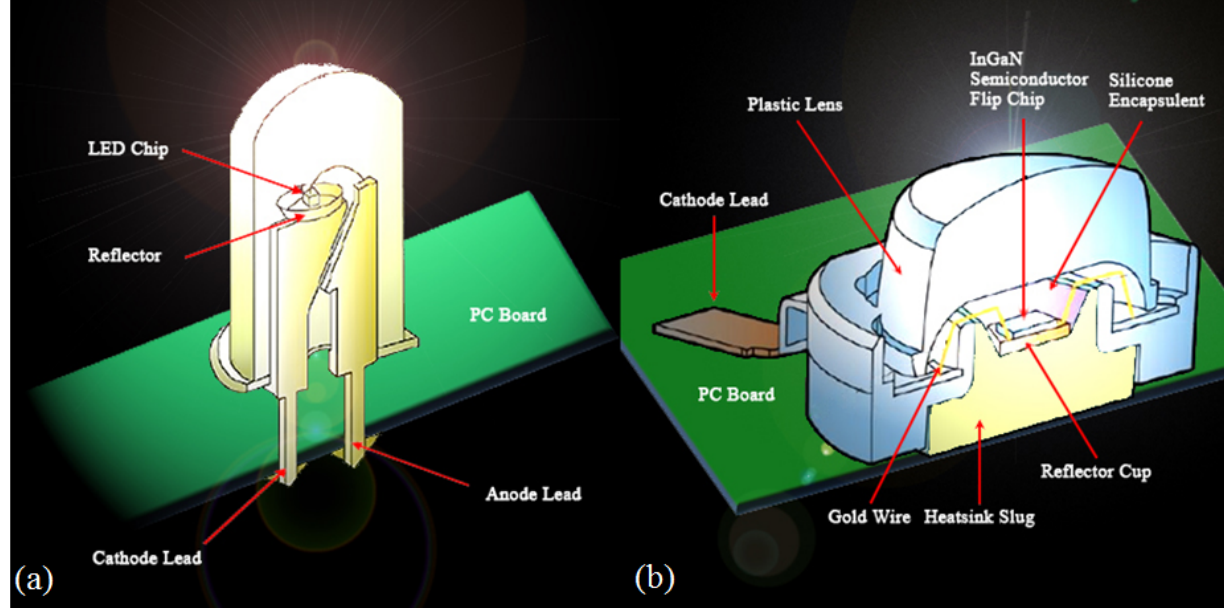
Figure 1. LED structure. ( a ) cylindrical LED; ( b ) chip